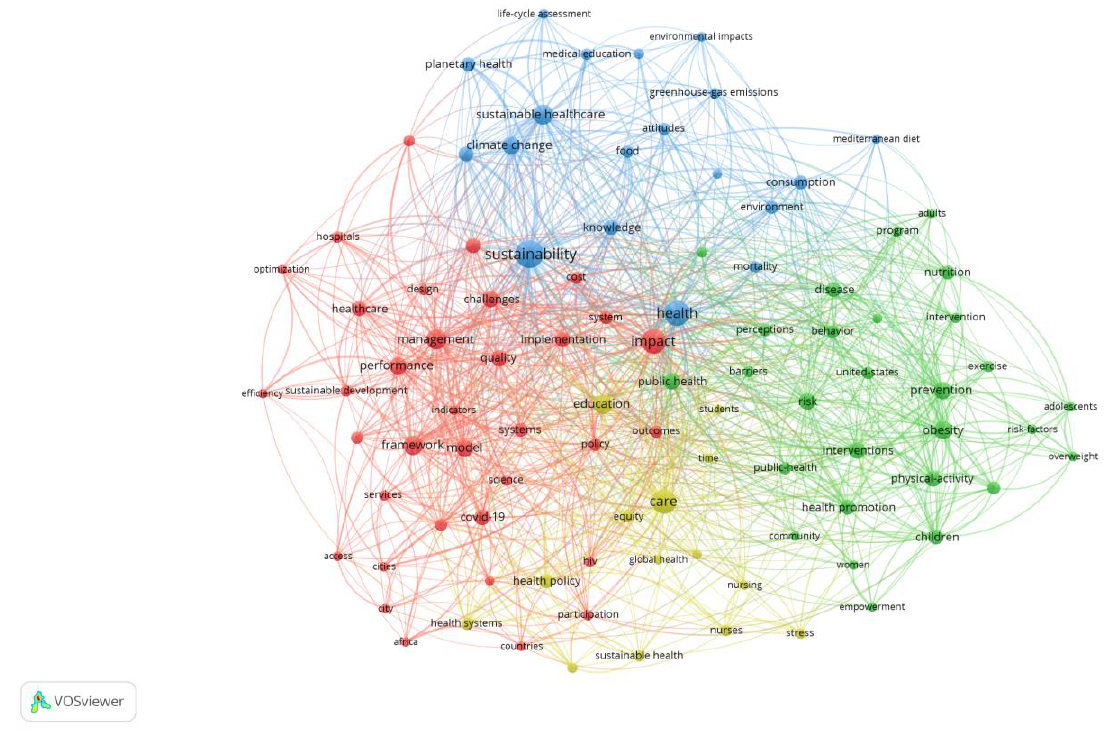
Figure 3. Keywords co-occurrence map.